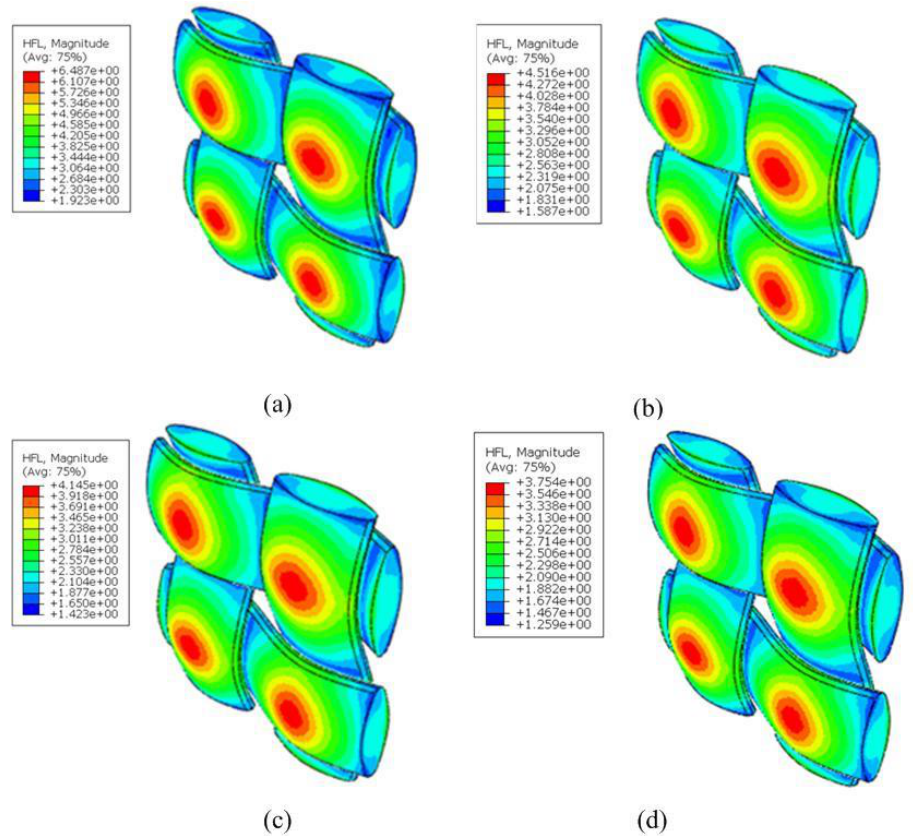
Figure 8. Distribution of heat flow of yarn with different volume fraction of HGBs: ( a ) ν B = 20%, ( c ) ν B = 30%, ( d ) ν B =